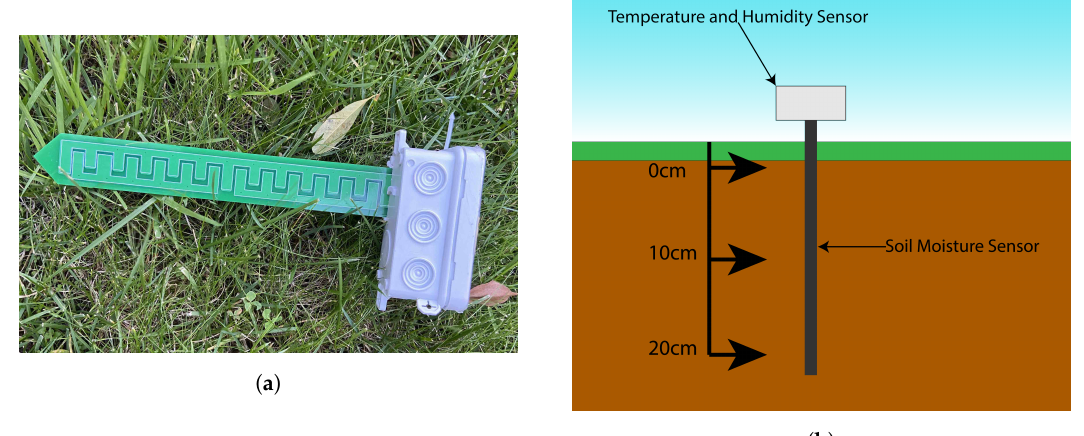
Figure 5. ( a ) Smart Node with Soil sensor; ( b ) Irrigation zones and sensor implementation.